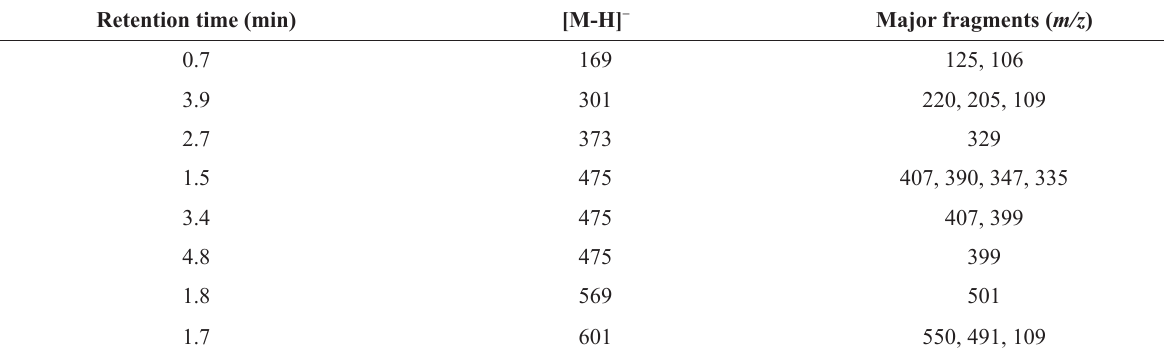
Retention times and ms/ms fragments of main ions in M. mondury geopropolis determined by uhplc-esi(-)-ms/ms in the negative ion